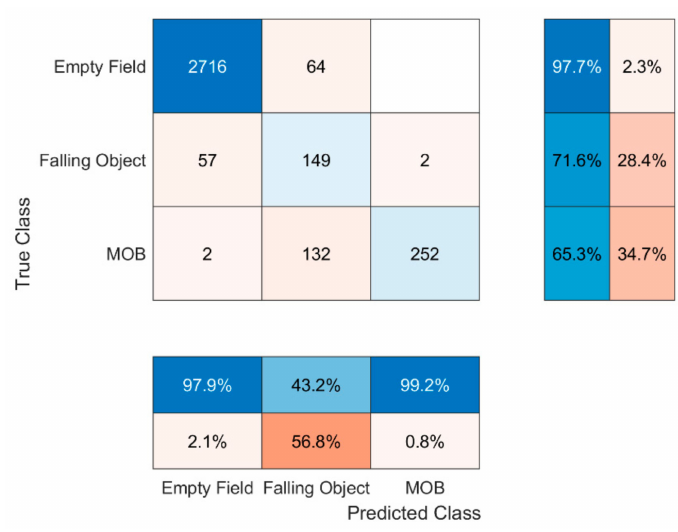
Figure 8. Fusion’s confusion